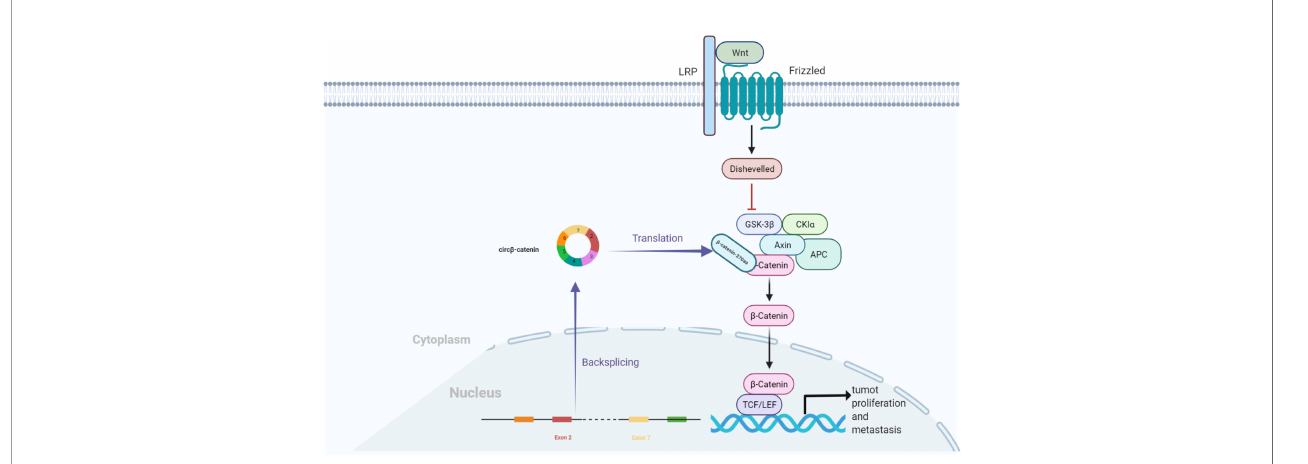
FIGURE 4 | circ b -catenin production of b -catenin isoforms by antagonizing GSK3 b , which induces b -catenin phosphorylation and degradation. Nuclear b -catenin interacts with the TCF/LEF complex, which triggers the transcription of target genes and promotes the proliferation of hepatocellular carcinoma